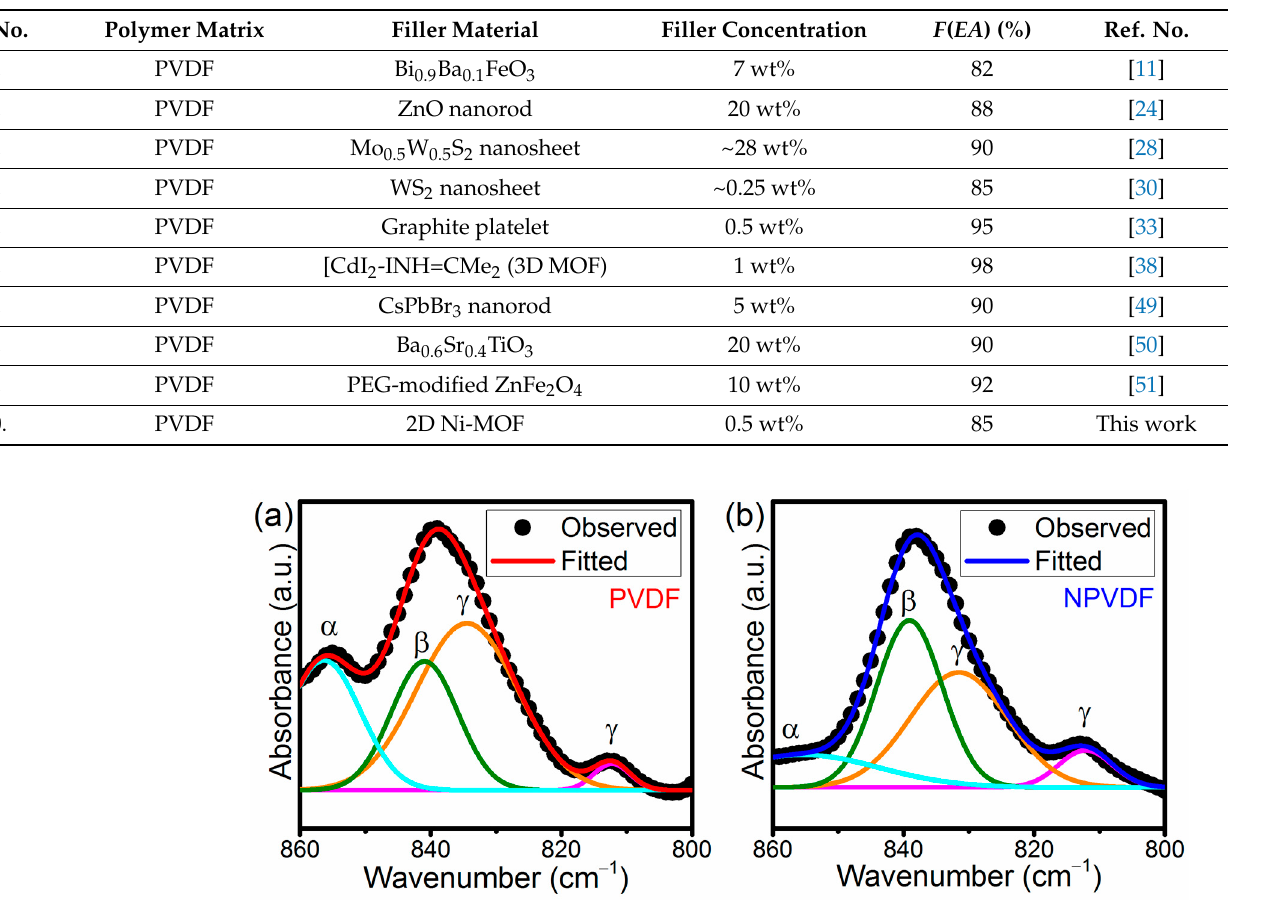
Figure 5. Gaussian curve fitting of the FTIR absorption spectra around 840 cm − 1 band corresponding to ( a ) PVDF and ( b ) NPVDF samples. (The deconvoluted absorption peaks at 855, 840, 833 and 811 cm − 1 corresponding to α , β , γ and γ phases, respectively, are presented in Cyan, Olive, Orange Magenta colours.)